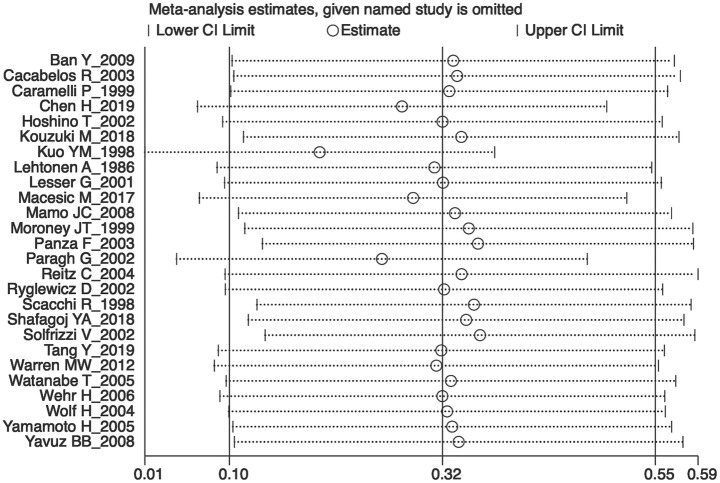
The plot in the sensitivity analysis of current meta-analysis (given named study was omitted).